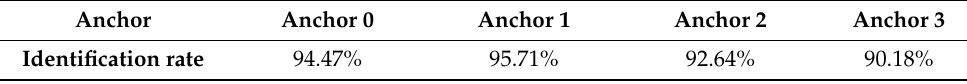
Figure 7. NLOS identification result (Experiment 1): ( a ) Anchor 0, ( b ) Anchor 1, ( c ) Anchor 2, ( d ) Anchor 3.